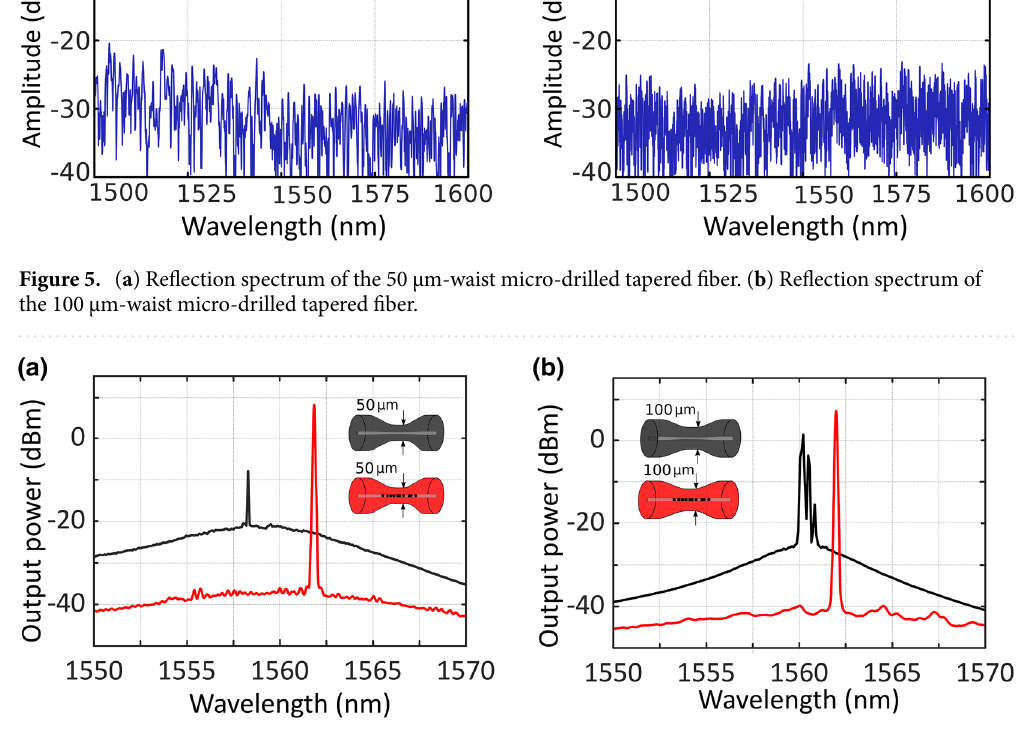
Figure 6. ( a ) Output spectra of the short-linear-cavity fiber laser, pumped by a 976-nm light at 350mW, when using a 50 µm-waist un-drilled (black line) or micro-drilled tapered fiber (red line). ( b ) Output spectra of the short-linear-cavity fiber laser, pumped by a 976-nm light at 350mW when using a 100 µm-waist un-drilled (black line) or micro-drilled tapered fiber (red